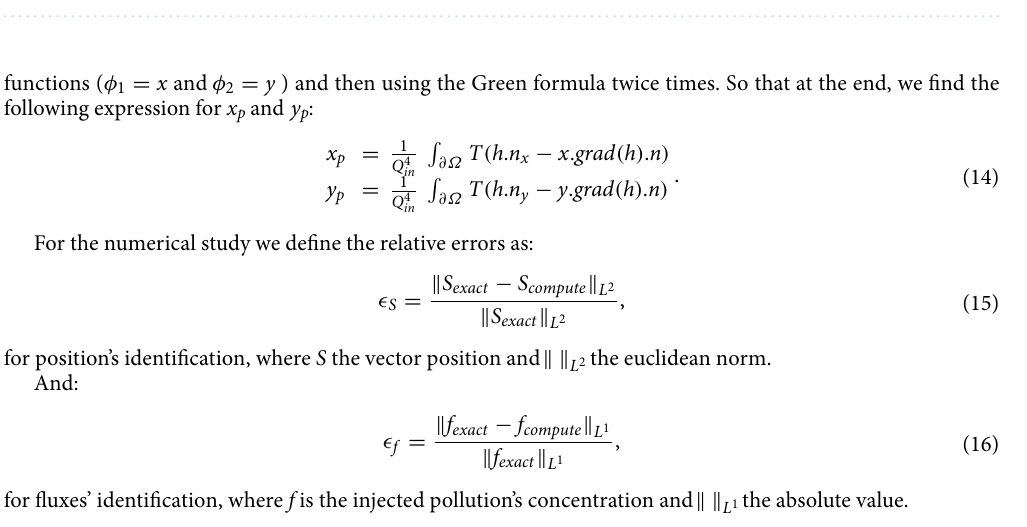
Figure 4. Rocky Mountain pollute concentration